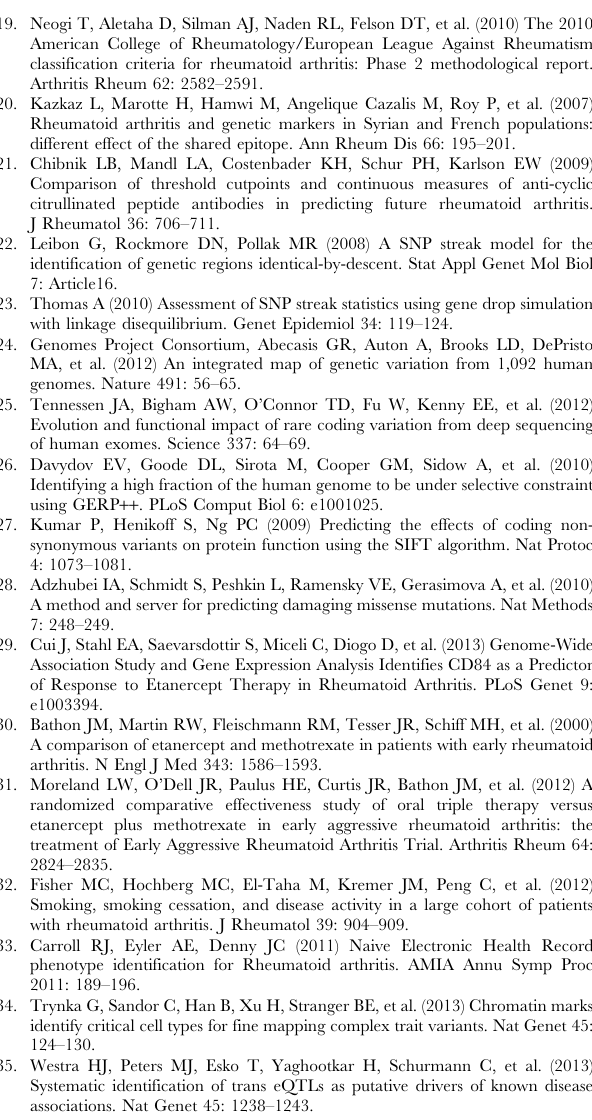
Table S5 Rare variants obtained from deep exon sequencing of PLB1 in the European RA case-control